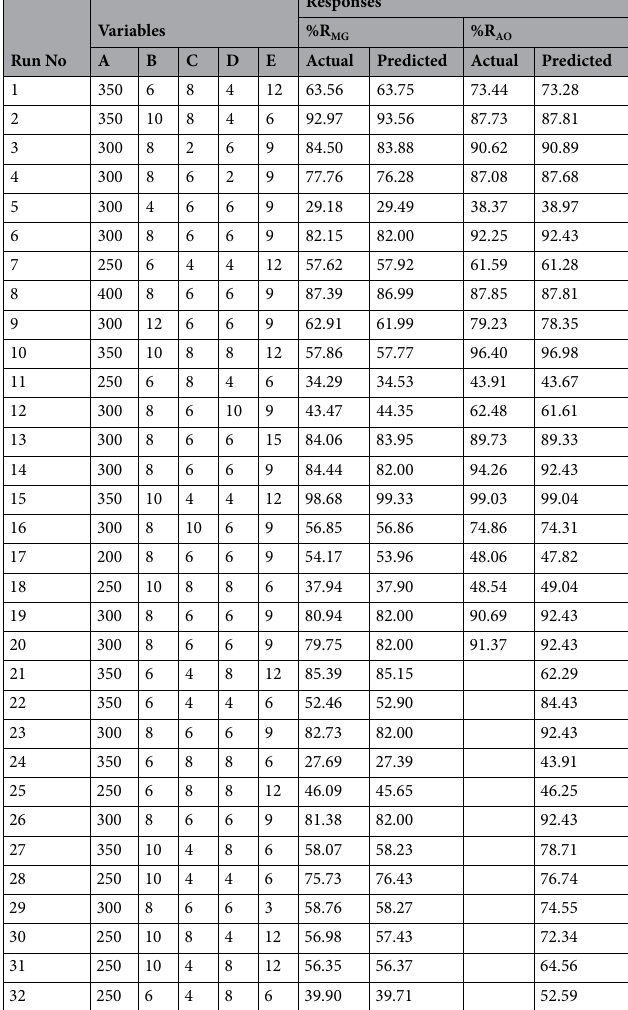
Table 5. CCD design of variables and their corresponding experimental and predicted removal of MG and AO. A: adsorbent dosage (mg), B: pH of the solution, C: MG concentration (mg L −1 ), D: AO concentration (mg L −1 ) and E: sonication time